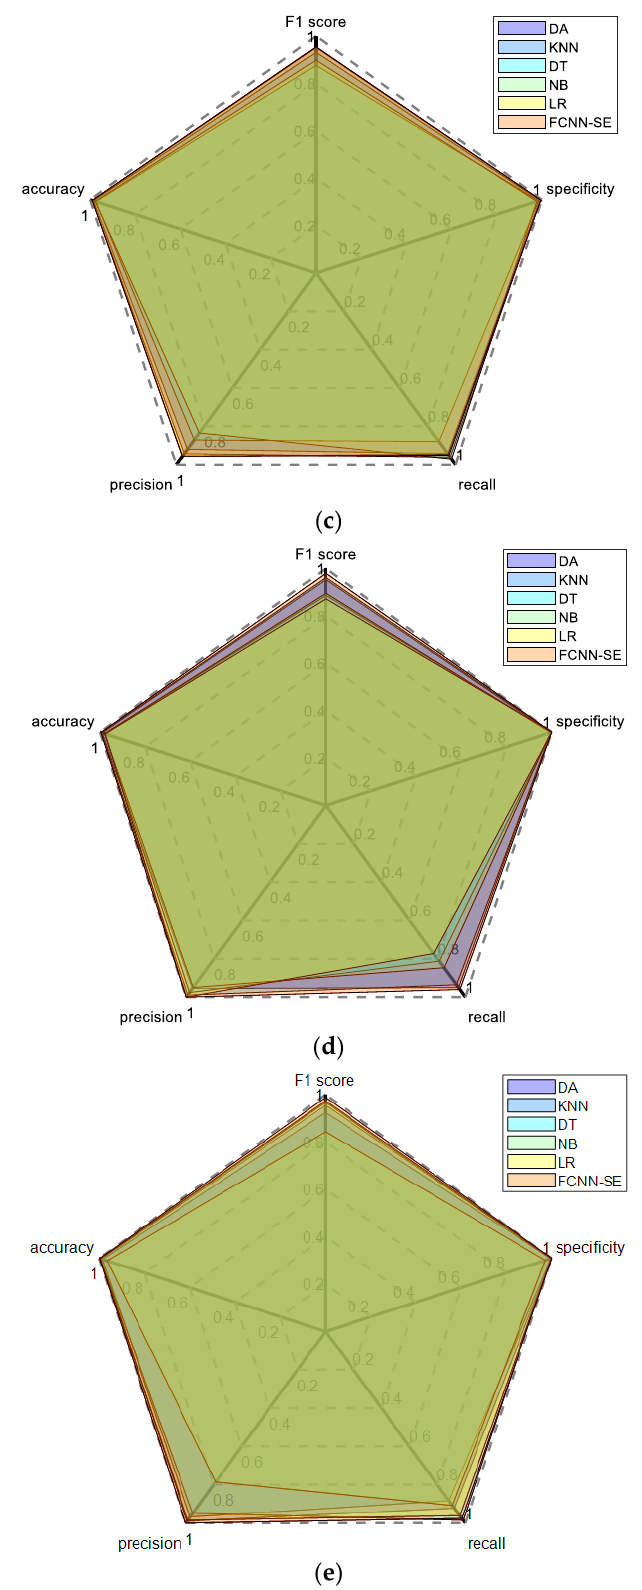
Figure 4. The radar chart used for comprehensive model performance evaluation: ( a ) class 1 data; ( b ) class 2 data; ( c ) class 3 data; ( d ) class 4 data; ( e ) class 5 data.